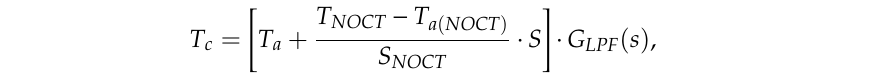
Table 2. Nomenclature.